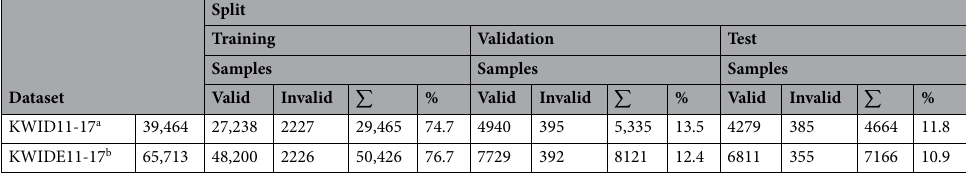
of identification images (100 most common classes): mean = 627.40, stdv = 245.06, min = 172 (T073B), max = 1442 (T019B) training stats (only valid images): mean = 482.00, stdv = 192.32, min = 139